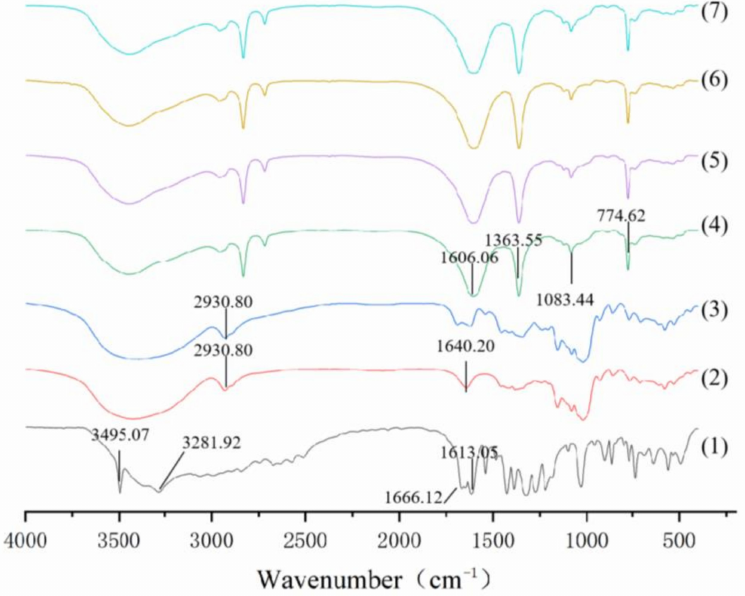
Figure 5. FT-IR spectra of (1) GA, (2) PS, (3) PG, (4) SA/PG beads, (5) SCN/PG beads, (6) SCT/PG beads, and (7) SCC/PG